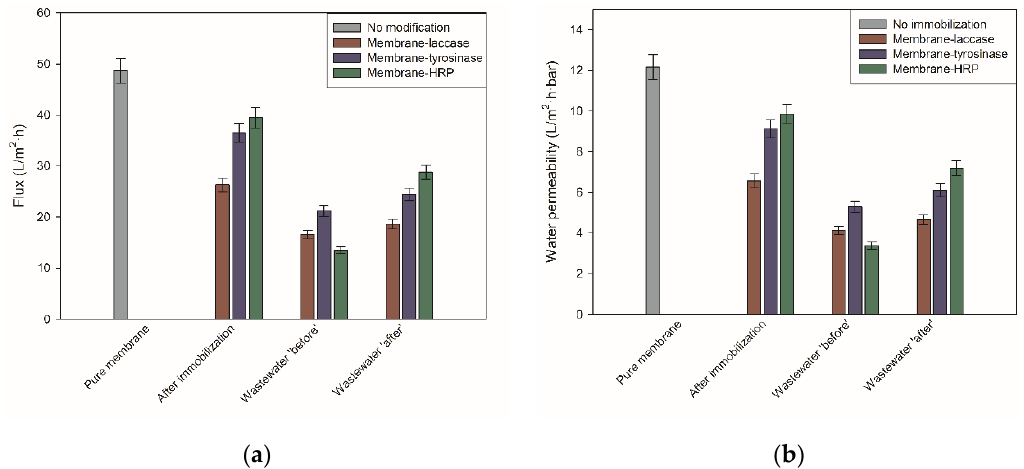
Figure 2. Characterization of the biocatalytic membranes produced in terms of changes in their ( a ) flux and ( b ) water permeability. All values are presented as a mean value of 3 experiments ± standard deviation.